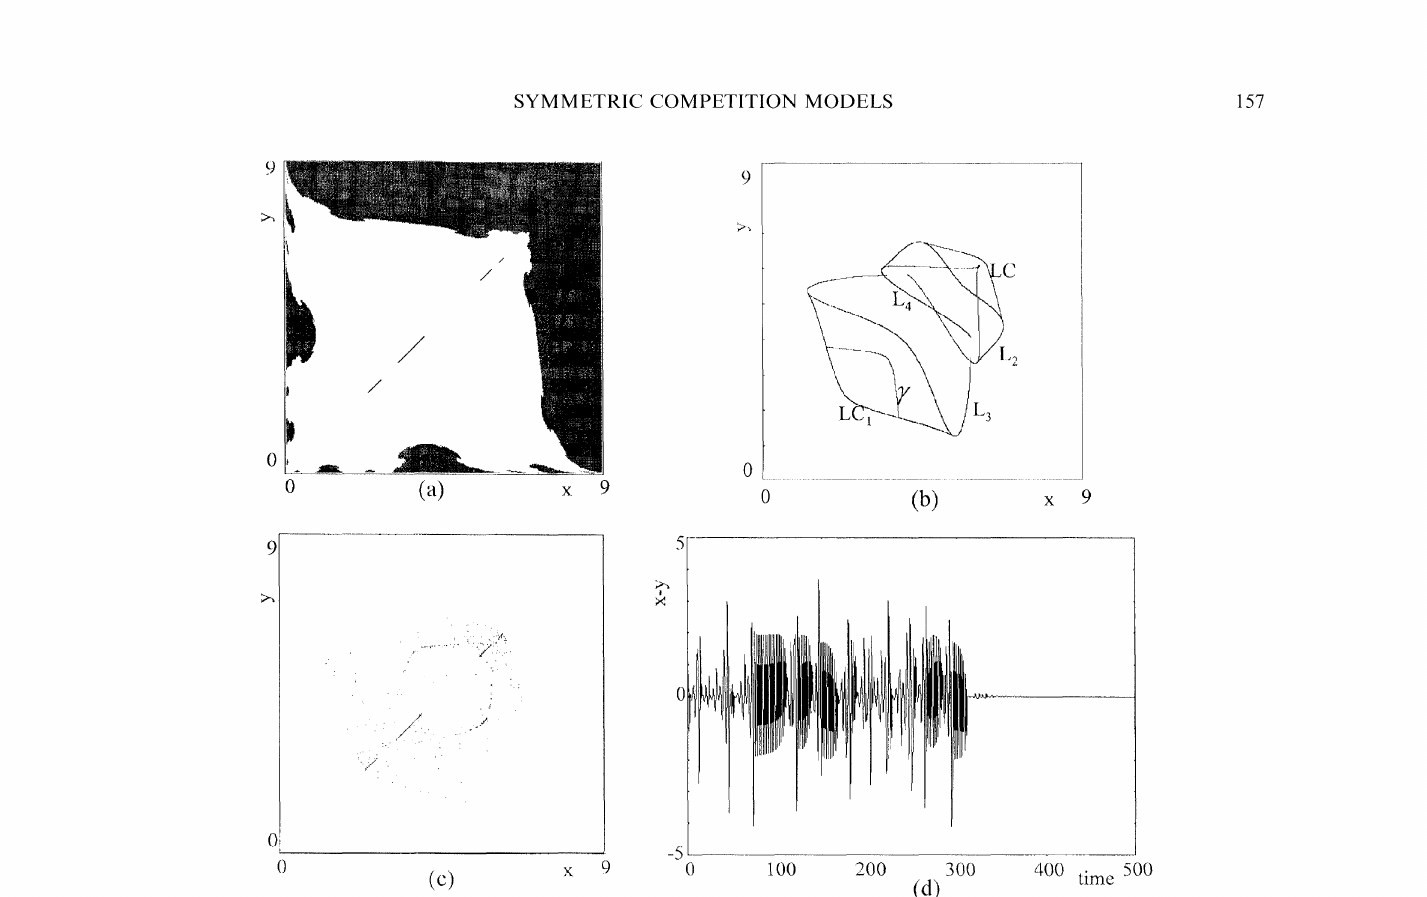
FIGURE 2 Numerical explorations of the dynamic behaviors of the symmetric brand competition model (12) with parameters /1 =/42=0.16, B= 10, k= and ,1 =/2=0.51496098 2(#2- 1)lB. (a) The white region represents the set of points that generate trajectories which synchronize on the 4-cyclic chaotic set A.,.; the points of the grey region generate interrupted trajectories, involving negative values of the state variables. (b) Boundary of the absorbing area around the Milnor attractor A,, obtained by the segments of critical curves LC T(y), LCI T(LC) LC/ T(LCI,_ ), k 2 4, images of the arc 7 c LC_I. (c) Points of the transient part of a typical trajectories which synchronizes. (d) The difference xt-yt, computed along the trajectory of Figure 2c, is represented versus time during the first 500